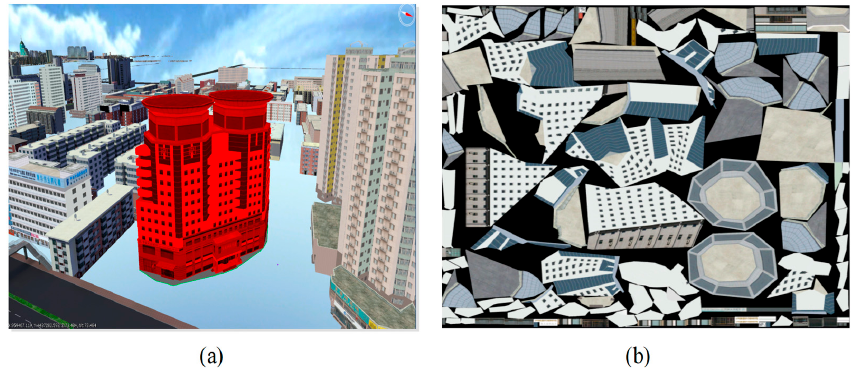
Figure 2. Experimental data: ( a ) original model-visualization effect with footprints; ( b ) texture image of the selected model.